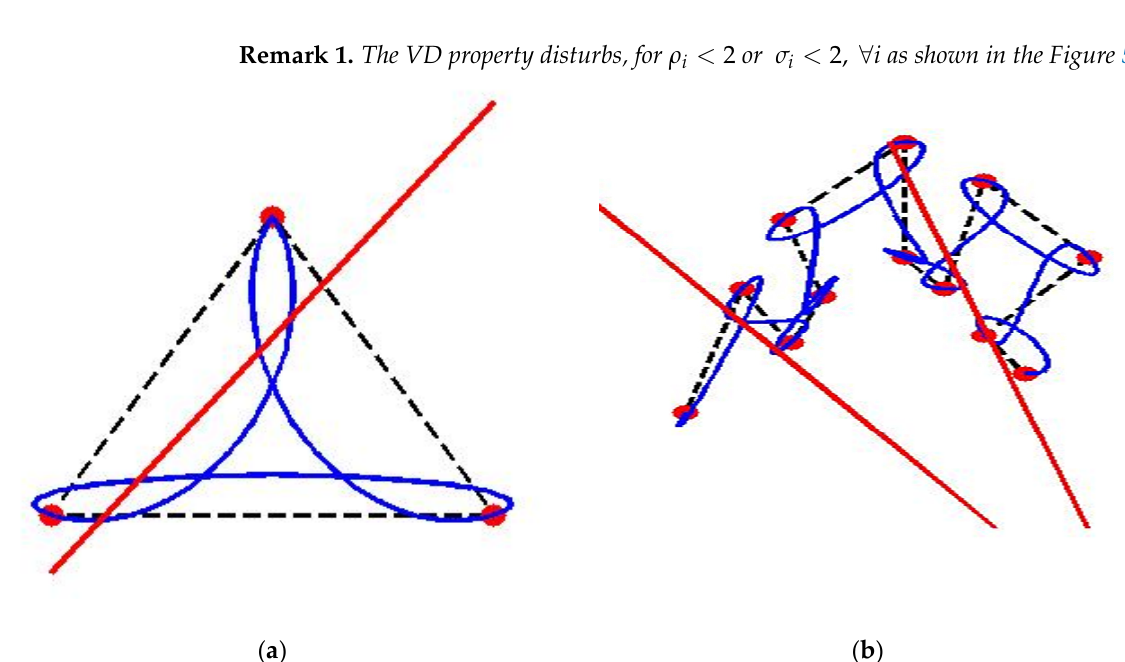
Figure 5. VD property disrupts for ( a ) 𝜌 (cid:3036) (cid:3404) 𝜎 (cid:3036) (cid:3404) 0.6 and ( b ) 𝜌 (cid:3036) (cid:3404) 𝜎 (cid:3036) (cid:3404) 0.4 for all intervals.